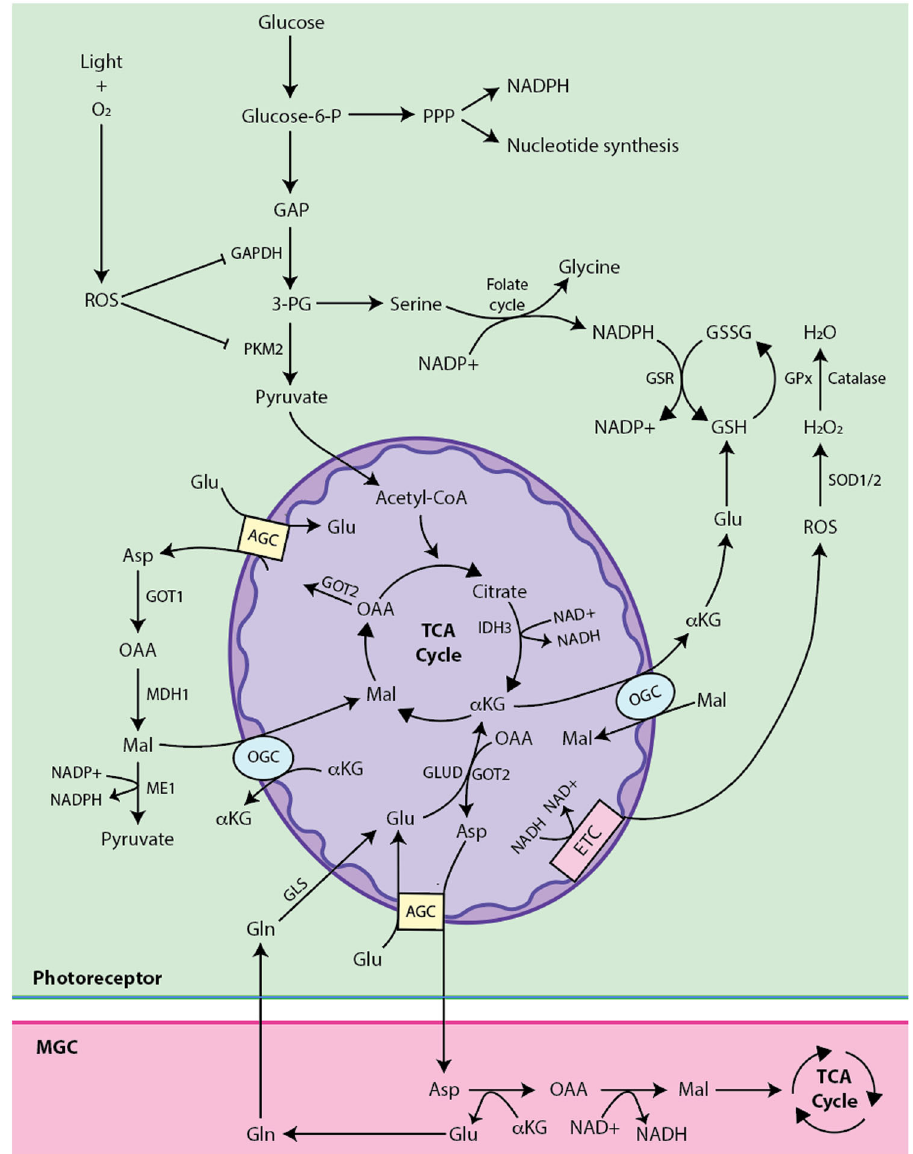
ROS (reactive oxygen species) that can be reduced via NADPH, GSH (glutathione), and antioxidant enzyme systems. NADPH is a key reducing equivalent that can be generated by the PPP (pentose phosphate pathway), serine metabolism, and ME1 (malic enzyme 1). NADPH reduces GSSG via GSR (glutathione reductase) to GSH, which is generated from serine metabolism and Glu (glutamate). GSH powers the enzyme system GPx (glutathione- peroxidase), which along with the other systems catalase and SOD1/2 (superoxide dismutase 1 and 2) helps reduce ROS. Nearby MGCs can provide Gln (glutamine) to photoreceptors, where it is converted to Glu and enters the TCA cycle or shunted out of the mitochondria as α KG (alpha ketoglutarate) via OGC (oxoglutarate carrier). IDH3 (isocitrate dehydrogenase 3), GAPDH (glyceraldehyde 3-phosphate dehydrogenase), PKM2 (pyruvate kinase muscle isoform 2), H 2 O 2 (hydrogen peroxide), Glucose-6-P (glucose-6-phosphate), GAP (glyceraldehyde 3-phosphate), 3PG (3-phosphoglyceric acid),